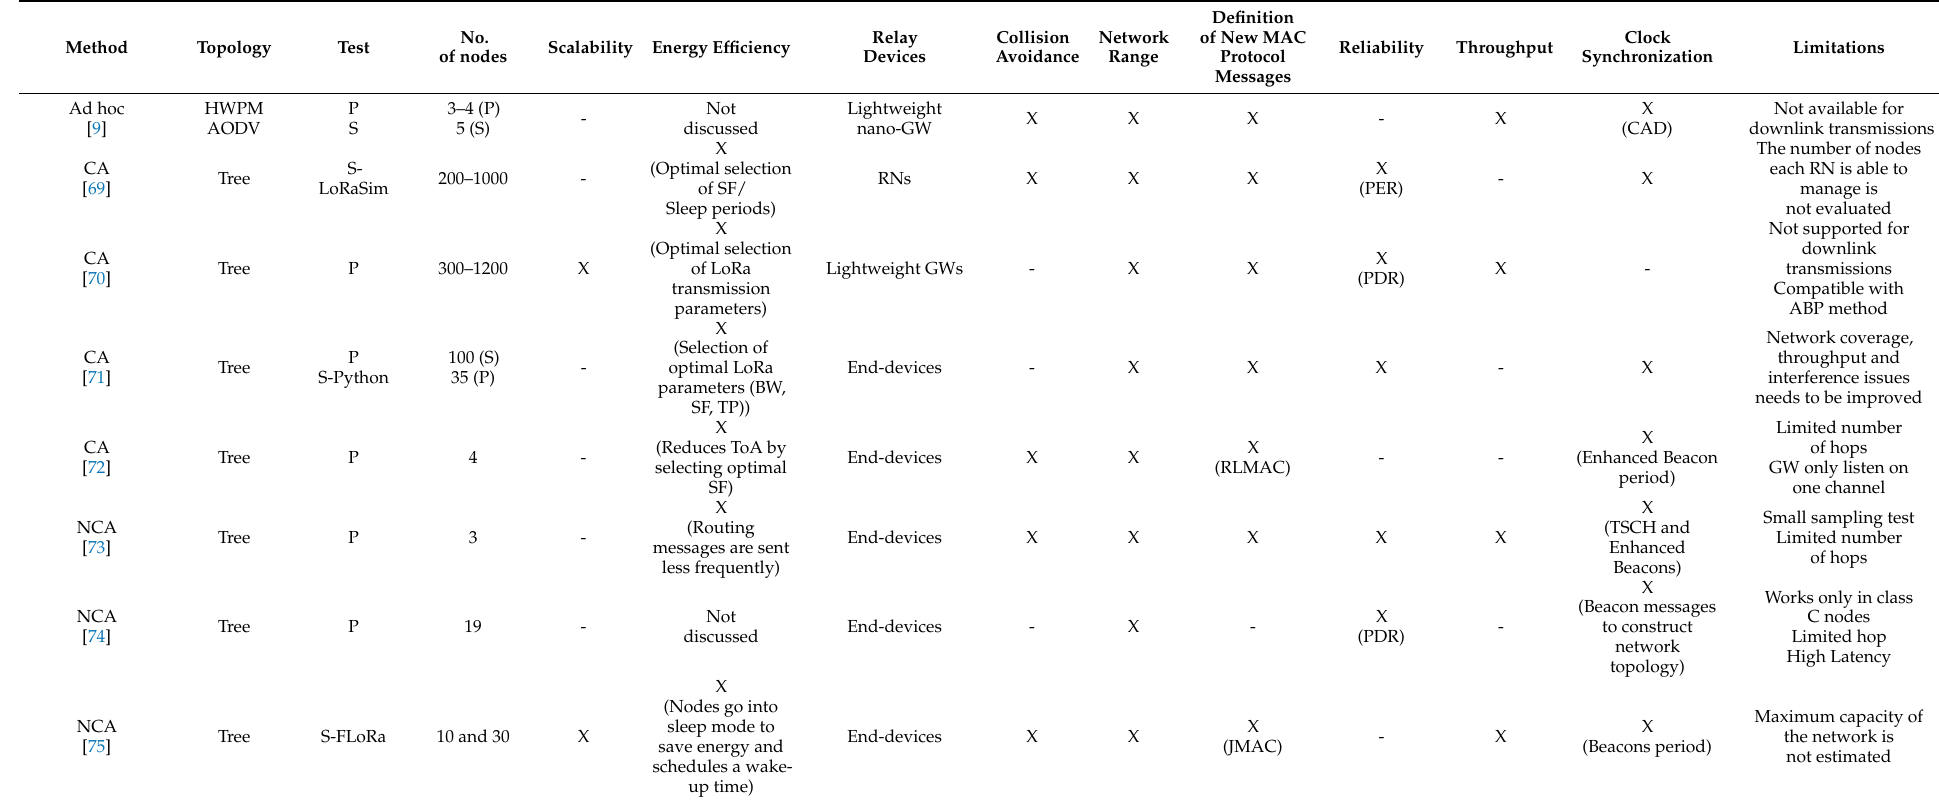
Table 6. Routing Protocols